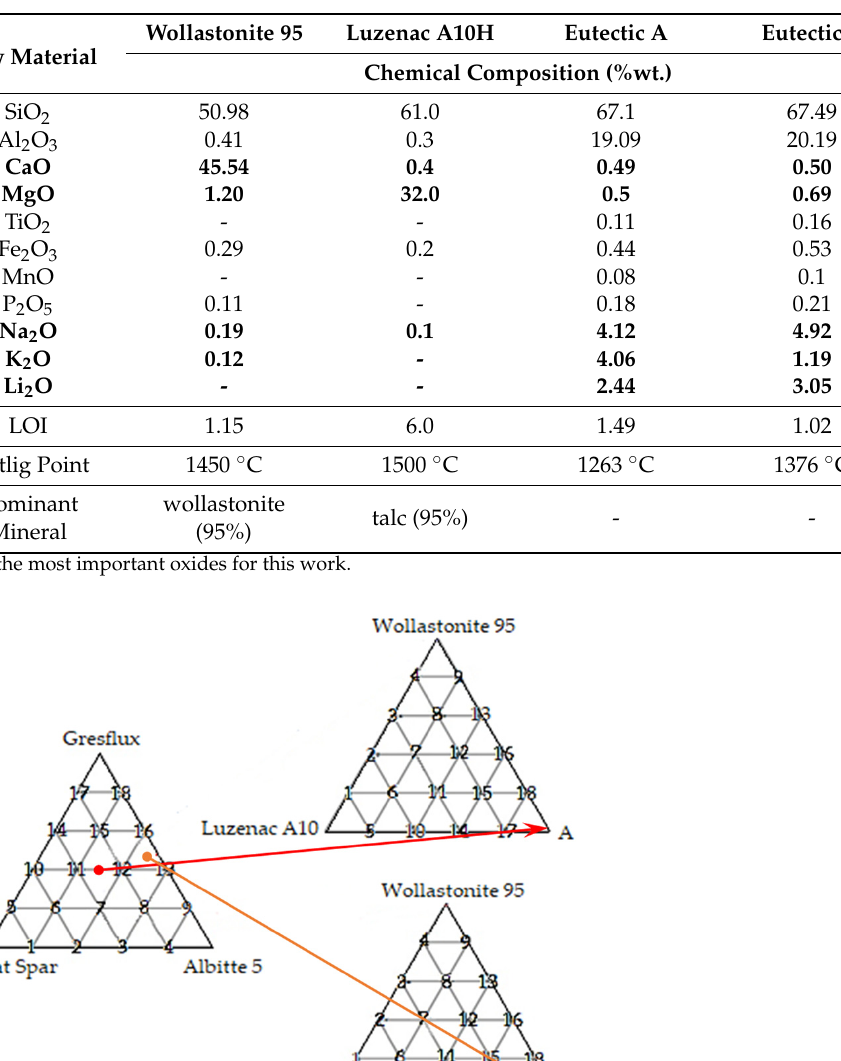
Table 1. Chemical composition of raw materials applied.